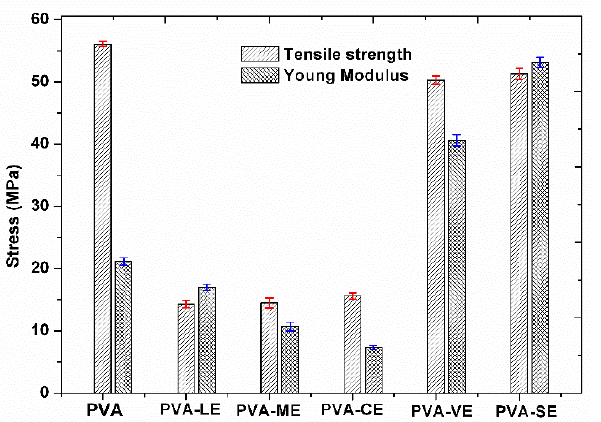
Figure 7. The values of tensile strength and Young modulus of the pristine PVA and PVA with plant extracts.